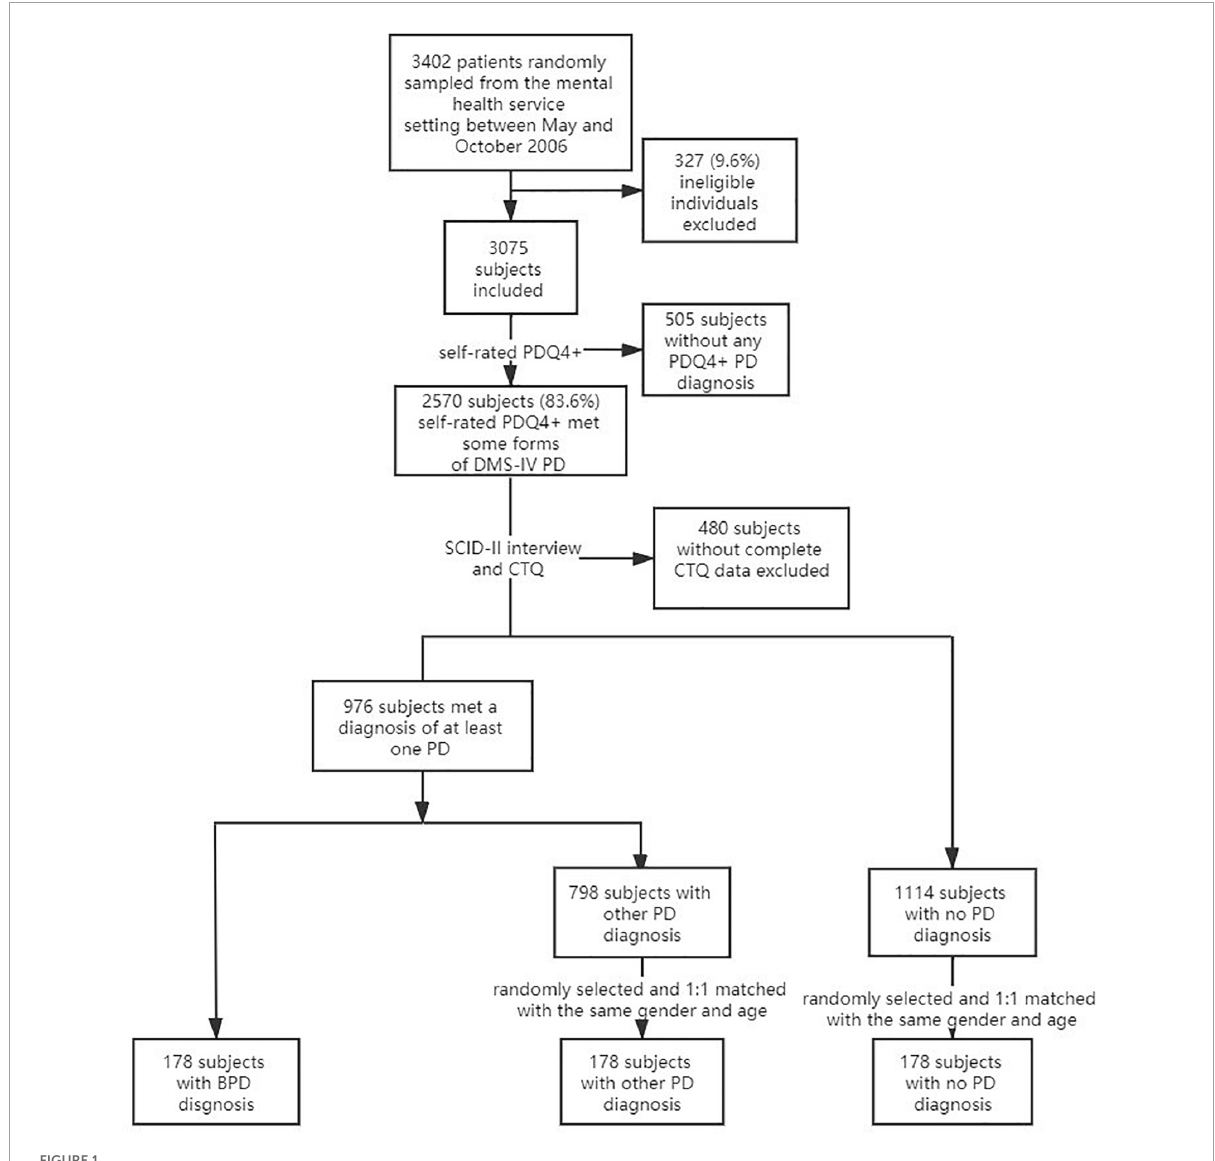
FIGURE1 The flow of subject selection and data